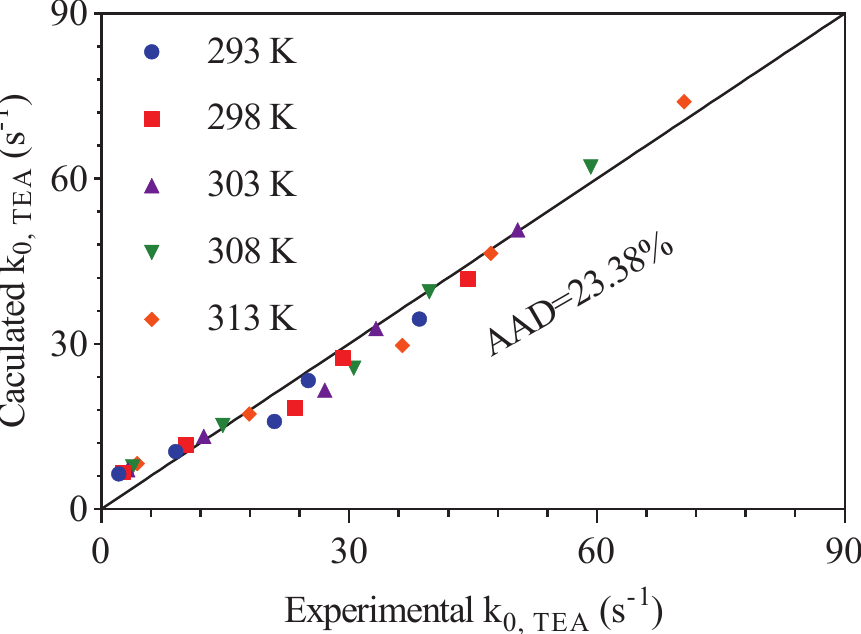
Figure 9. The comparison of experimental and calculated pseudo first–order reaction rate constant ( k 0, with CA